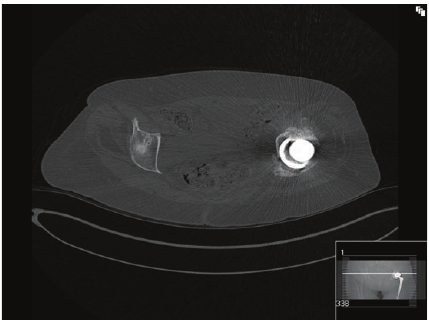
Figure 4: Pelvic CT scan confirming the acetabular fracture and displacement of acetabular component of the total hip